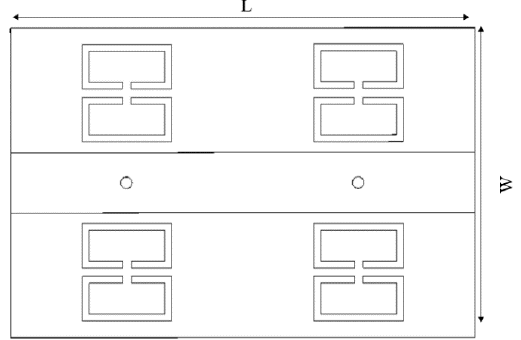
FIGURE.3. TOP VIEW OF PROPOSED SYMMETRICAL RING RESONATOR BANDPASS FILTER.